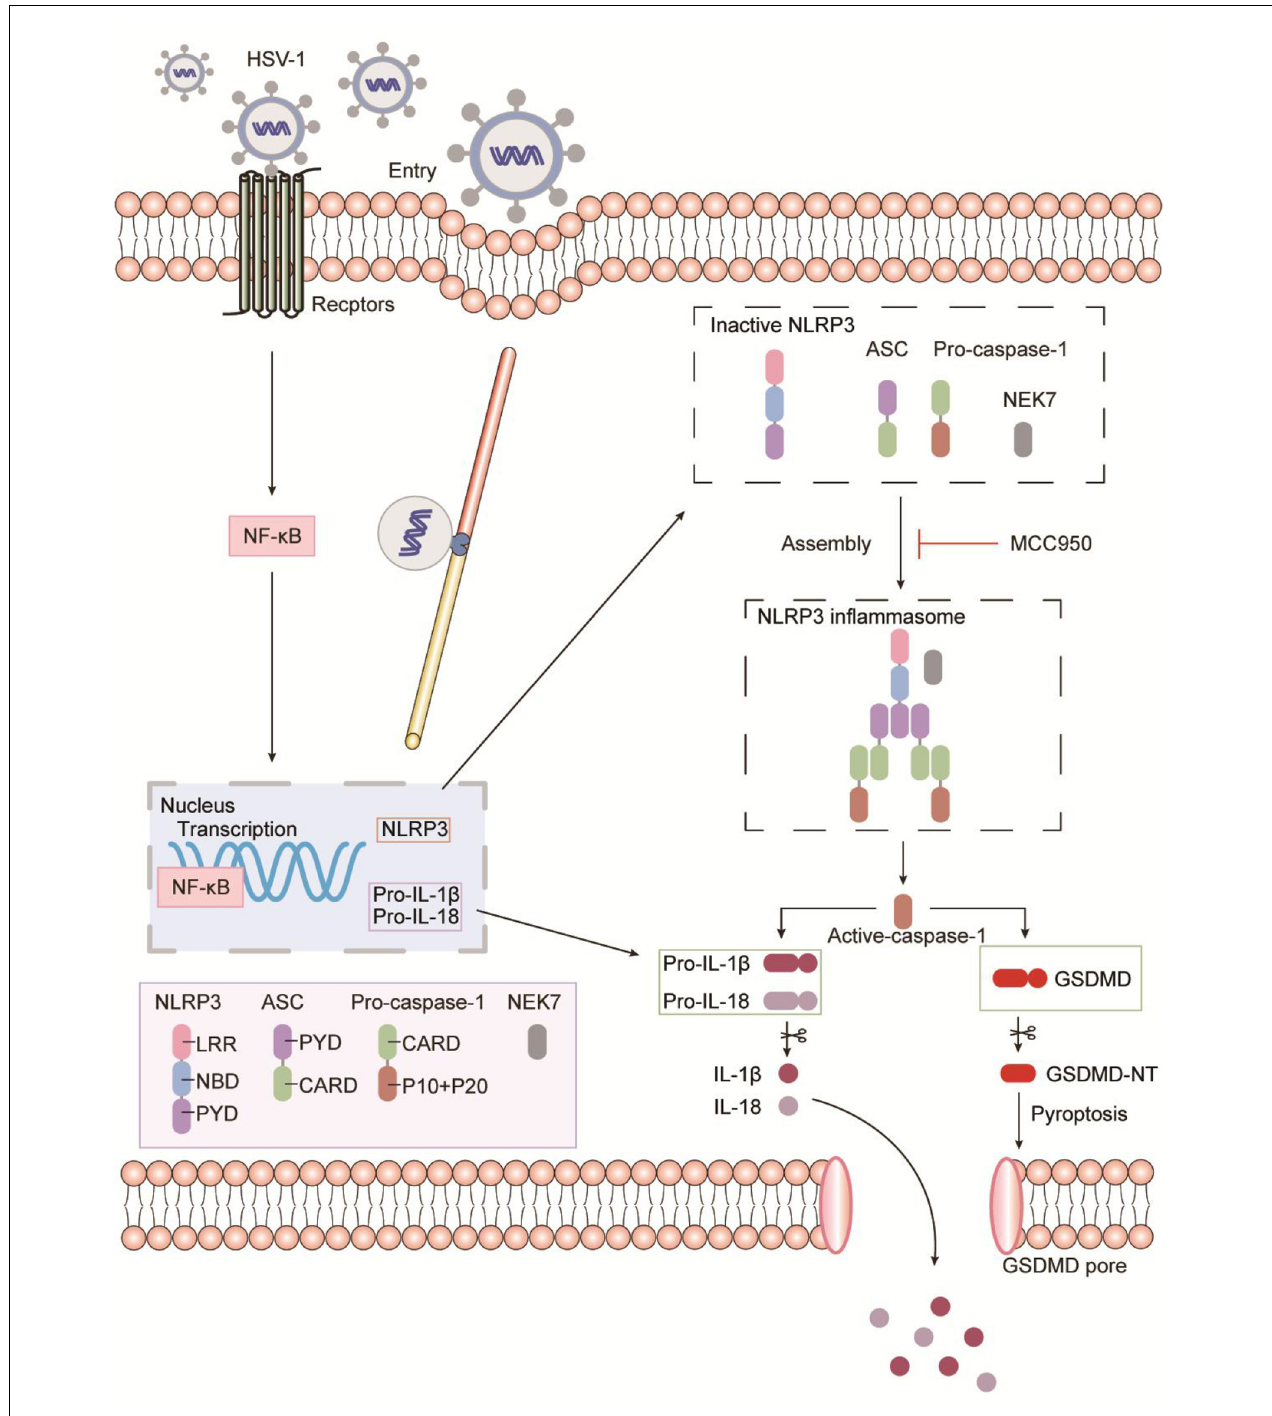
FIGURE 6 | Schematic representation of HSV-1 induces microglia pyroptosis and inflammation by activating the NLRP3 inflammasome. During HSV-1infection, the pattern recognition receptor (PRR) activates the NF- κ B signaling pathway, which causes the transcription and expression of critical proteins such as NLRP3, pro-IL-1 β , and pro-IL-18. Caspase-1 cleavage, Gasdermin D-dependent pyroptosis, and IL-1 β release occur after the NLRP3 inflammasome is formed. NLRP3 inflammasome selective inhibitor MCC950 inhibits HSV-1 induced Gasdermin D-dependent pyroptosis.